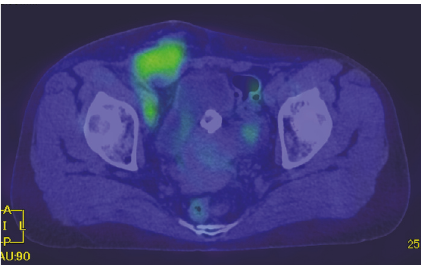
Figure 2: Apparent accumulation of 18 FDG at the right groin site and right pelvic lymph nodes on